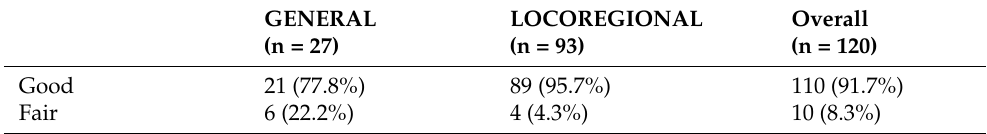
Table 4. Number and percentage of animals showing good and fair recovery in the general group compared with the locoregional group (involving EPIDURAL, QLB and TAP). Significative difference was found between both groups ( p = 0.01). No significative differences were found among